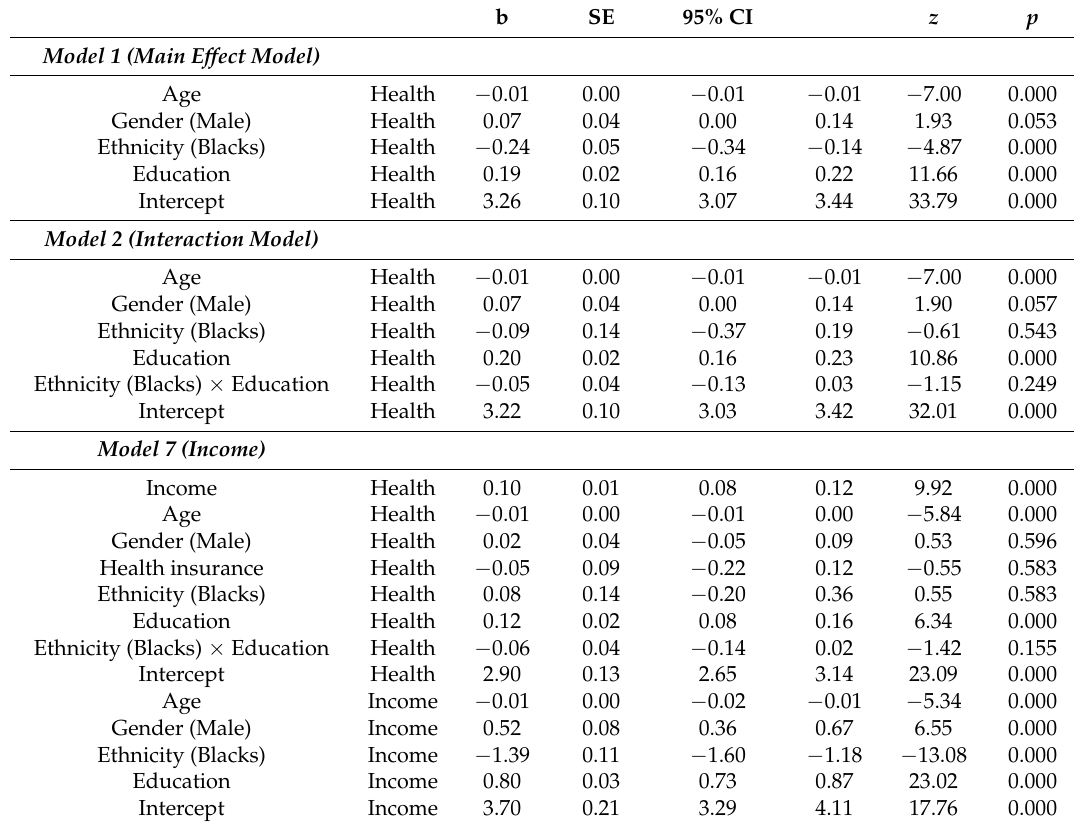
Table 1. Summary of structural equation models